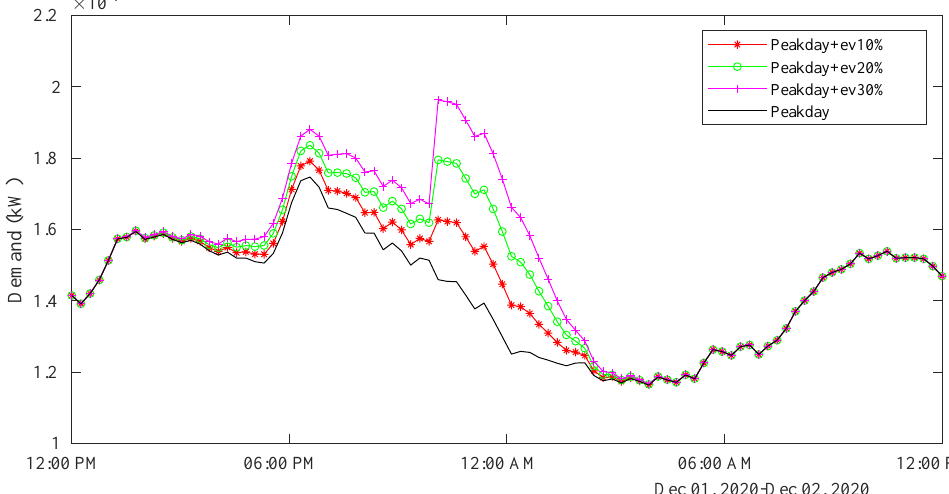
Figure 12. Load demand of the PEA when the TOU pricing policy is applied with T b = 10:00 p.m. and normal distribution of S i